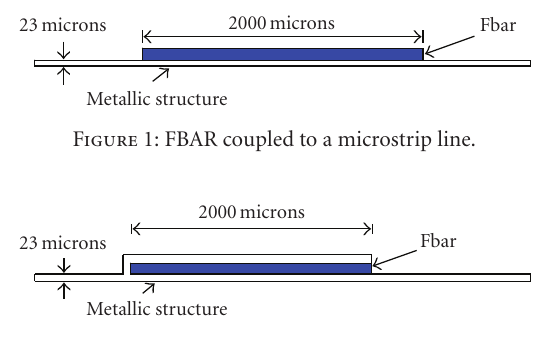
Figure 2: FBAR coupled to a microstrip hairpin with side coupling.